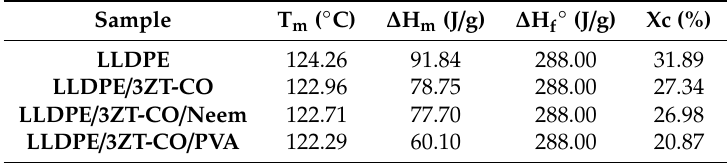
Table 2. The degree of crystallinity profile of LLDPE and LLDPE composites.